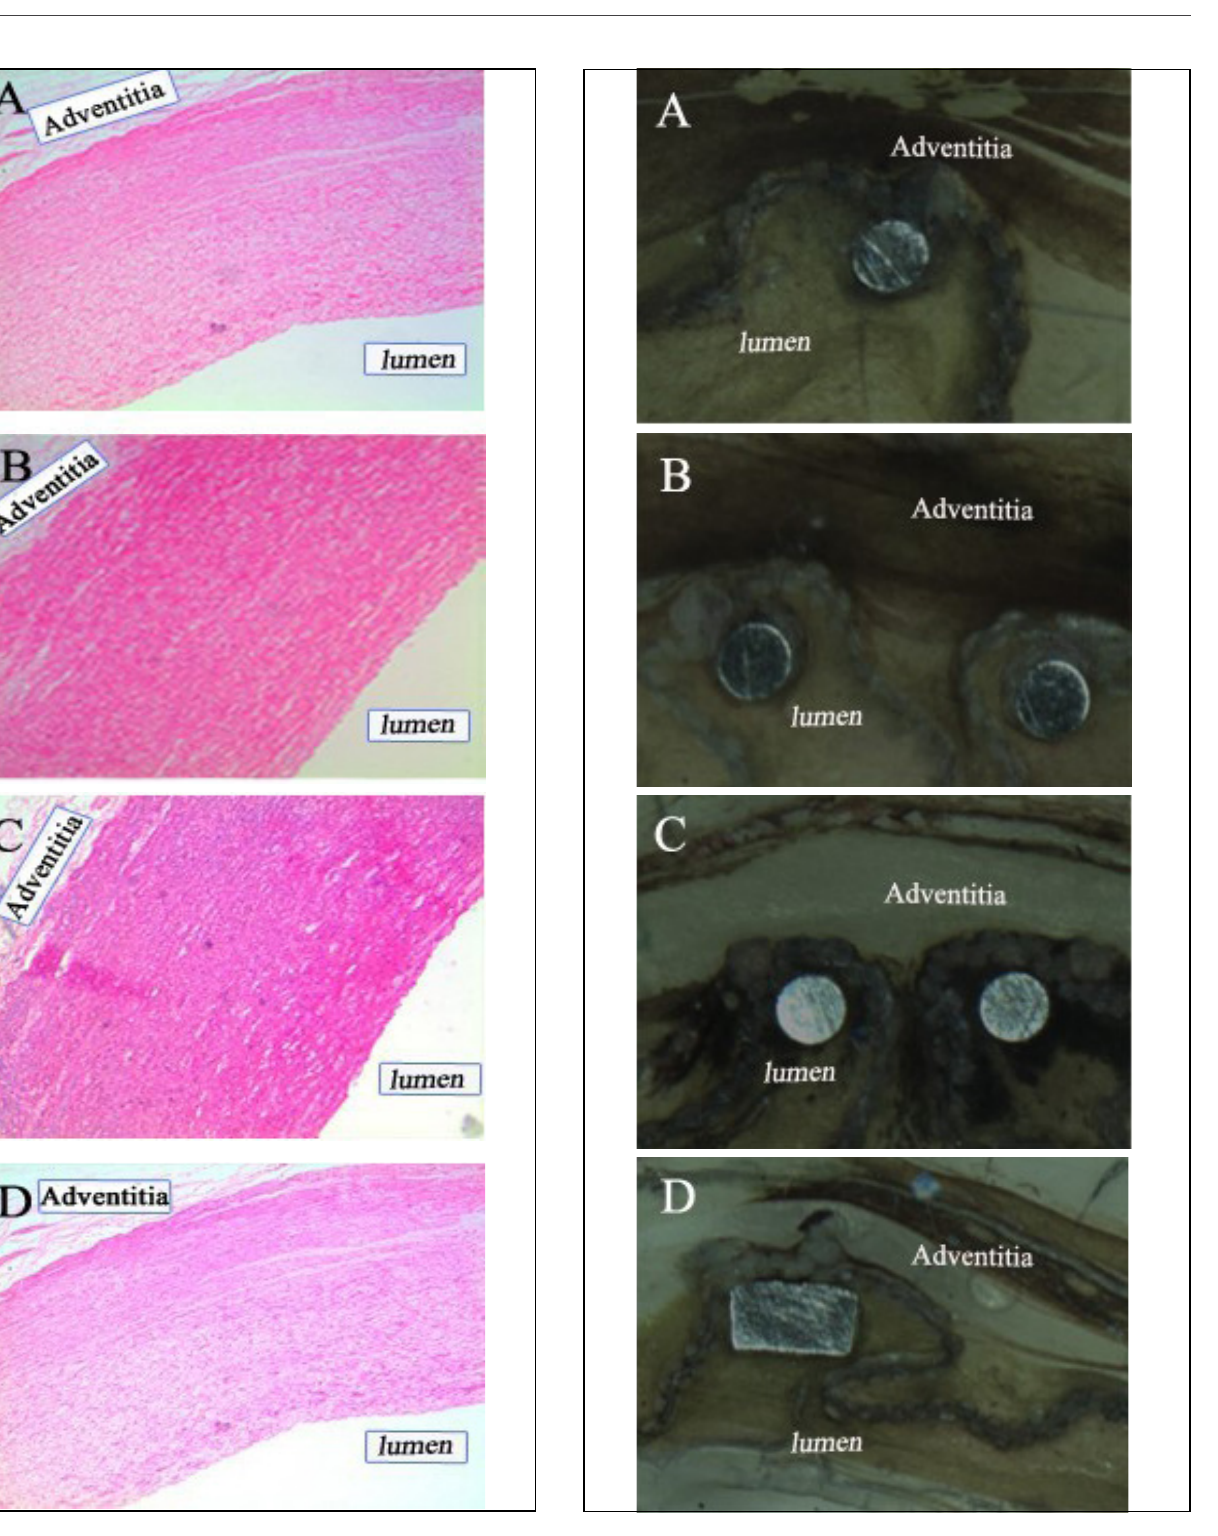
Fig. 7 - Histopathological changes in thoracic aorta with no stent-graft. (A) Thoracic aorta of 3 months after implantation. (B) Thoracic aorta of 6 months after implantation. (C) Thoracic aorta of 9 months after implantation. (D) Thoracic aorta of 12 months after implantation. Magnification, ×100.